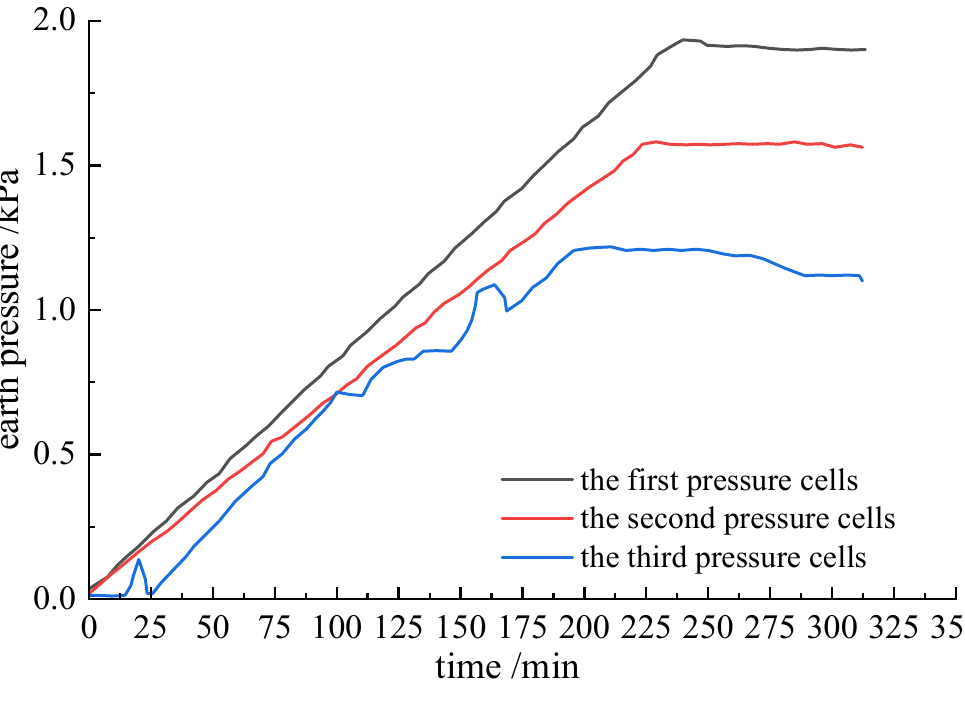
Figure 4. Change in soil pressure inside the slope during